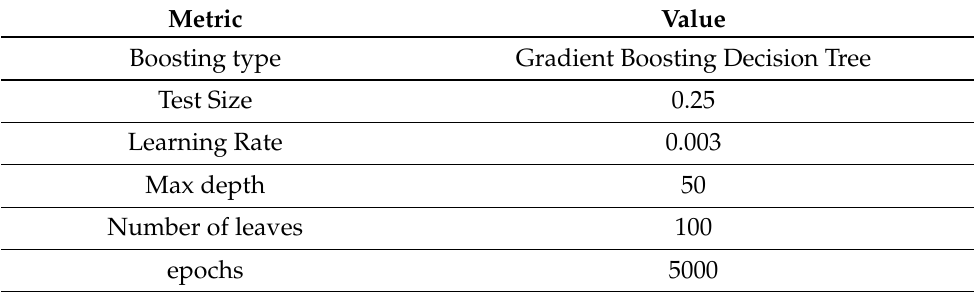
Table 5. Regression